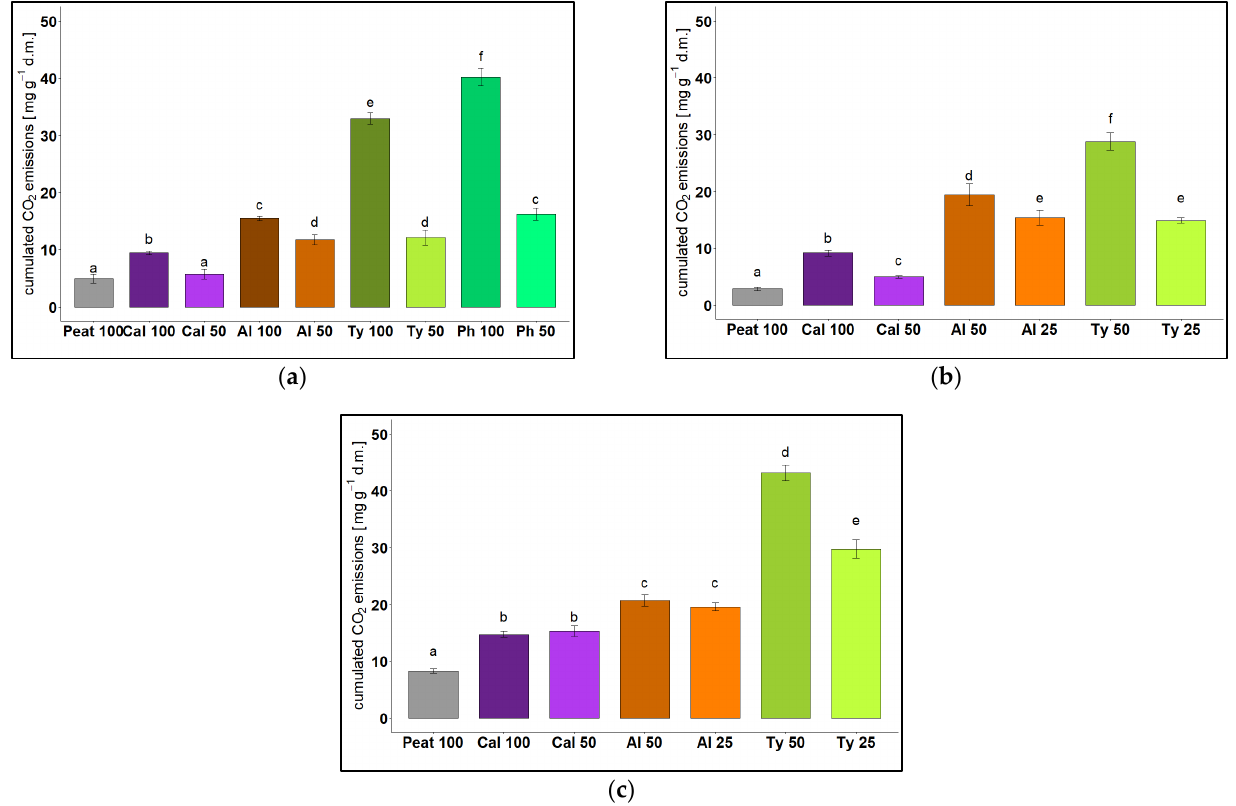
Figure 3. Cumulated CO 2 emissions of not limed processed raw materials and their mixtures over 13 days ( a ) stage 1 (n = 5, except Peat 100 n = 19) and ( b ) stage 2 (n = 5) as well as of ( c ) limed treatments (pH 6) in stage 2 (n = 5). Variance analysis: Kruskal – Wallis, post hoc tests: pairwise t test, p < 0.05. Different letters indicate significant differences among treatments.